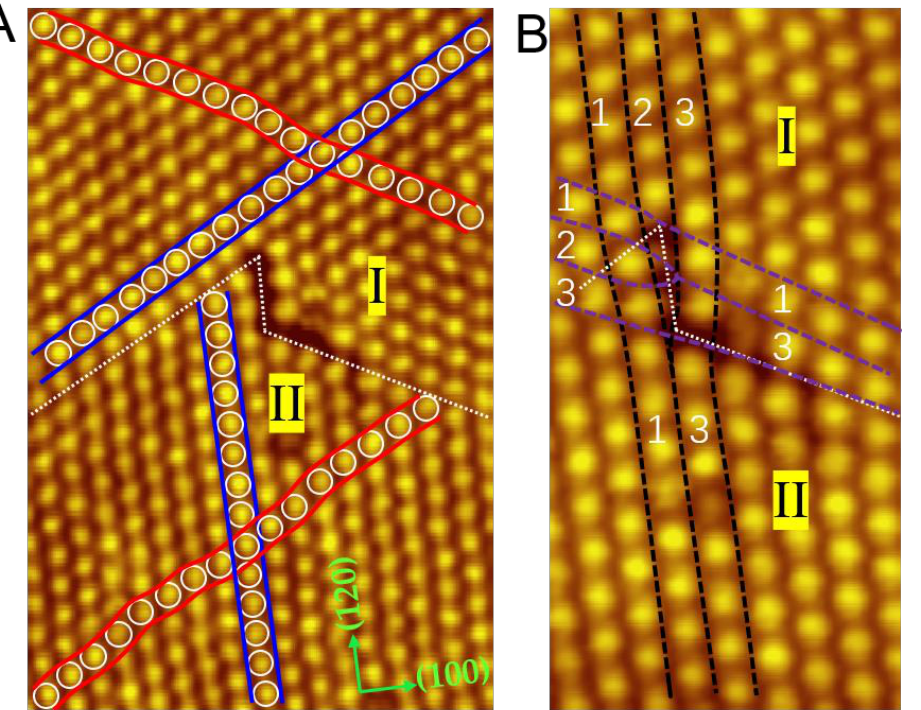
Figure 3. Two neighboring wavy domains (I and II) with different directions for the straight align- ments. ( A ) Edge dislocation appears at the domain boundaries (white dotted lines), 23 × 15 nm, 2.8 V. ( B ) Close-up view of the edge dislocation as marked by the black and purple dotted curves, 7.5 × 13.5 nm, 3.0 V.